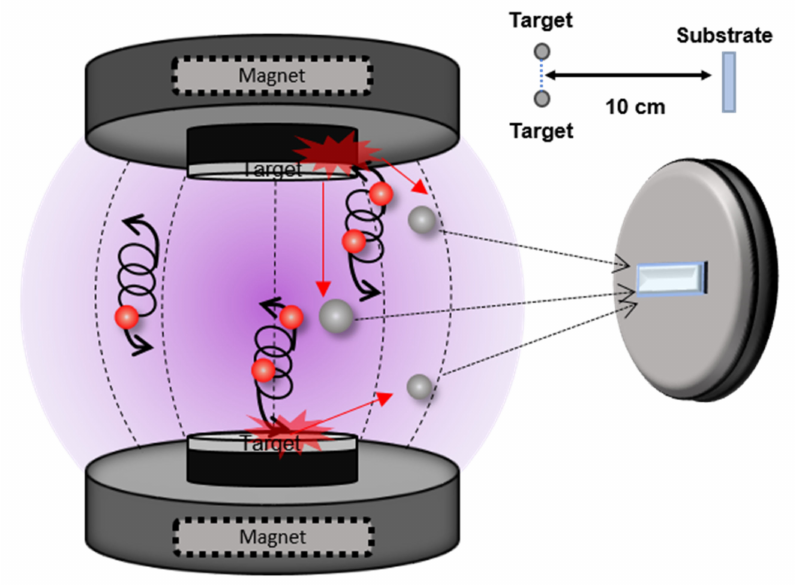
Figure 1. Schematic of the FTS